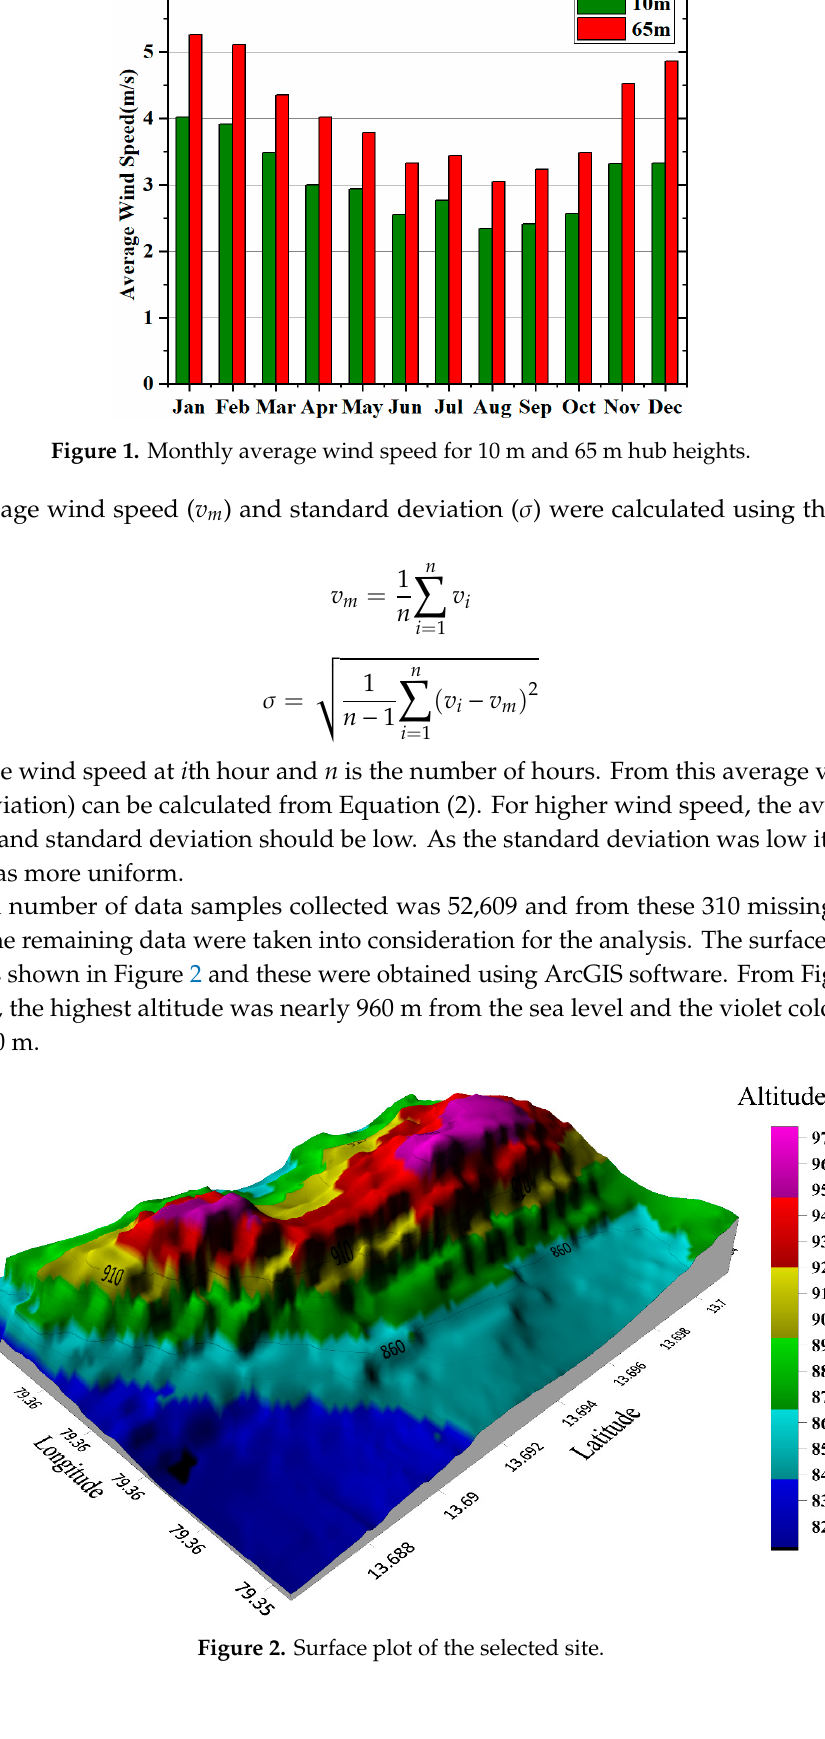
Figure 2. Surface plot of the selected site.